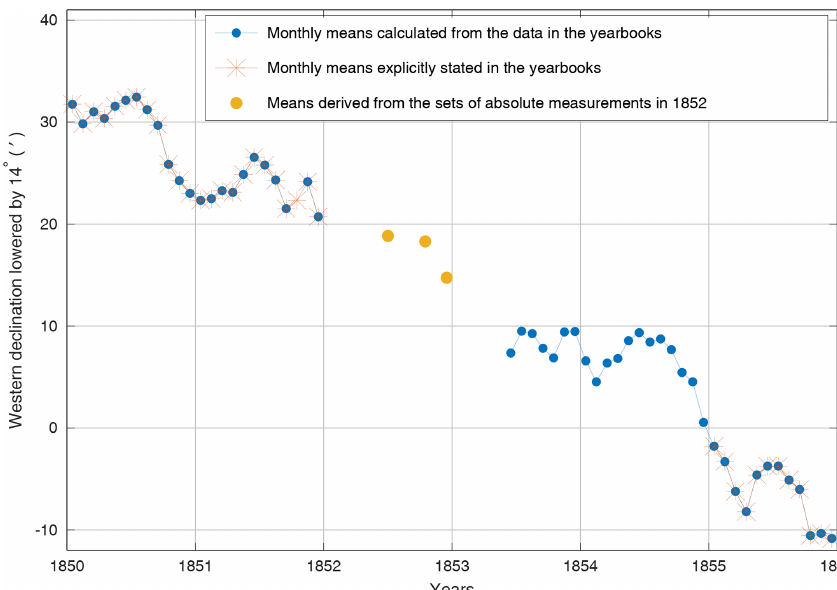
Figure 2. Time series of monthly averages of declination (western), which was observed between 1850 and 1855 at the Clementinum observatory in Prague at 22:00 Göttingen civic time. The yellow dots supplement the back-calculated results of the absolute measurements for 1852 at about the time of the summer solstice, the autumn equinox, and the winter solstice.